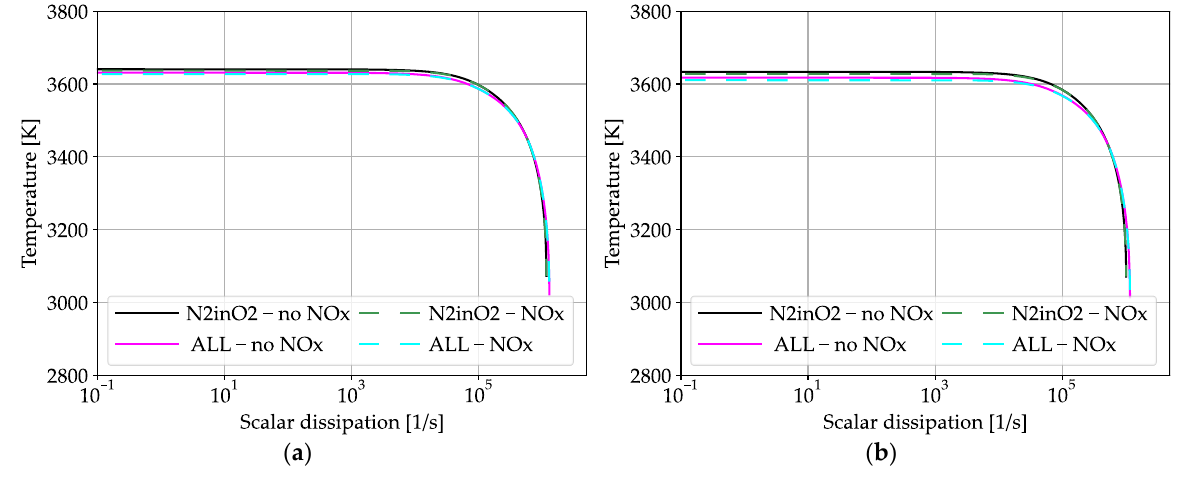
Figure 5. Temperature over scalar dissipation at the respective stoichiometric point comparing the influence of NOx chemistry at 10 MPa for different pollutions: ( a ) on the fuel side (N2 and ALL-F) and ( b ) pollution of the oxygen and both media (N2inO2 and ALL).